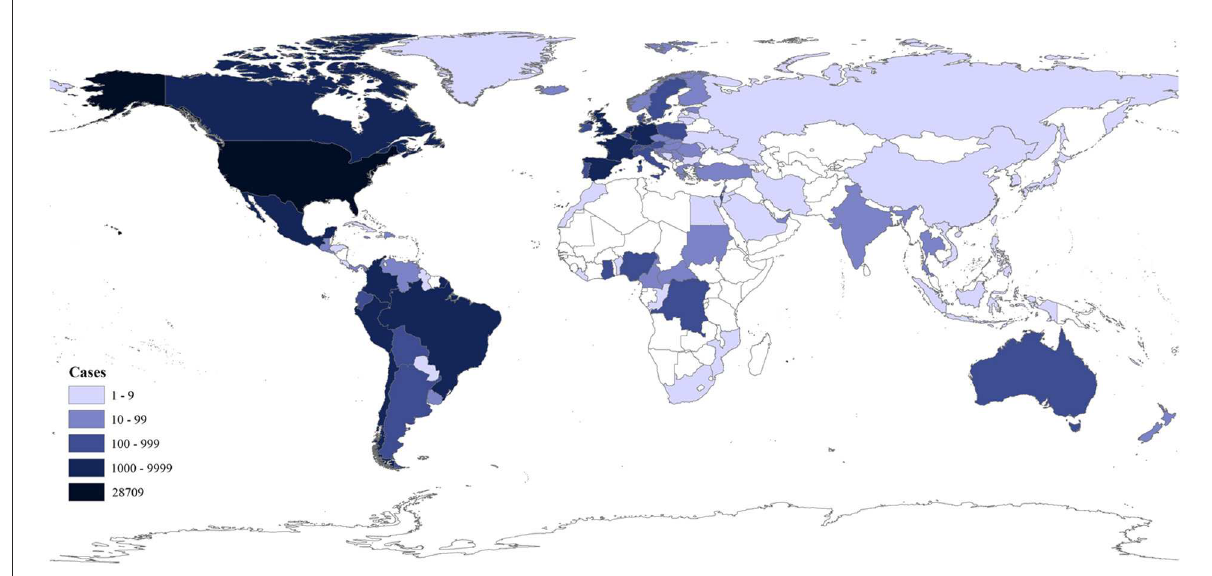
FIGURE1 Distribution of the cumulative confirmed human MPX cases in 2022 as of November 7, 2022 as per the data from the CDC (1).